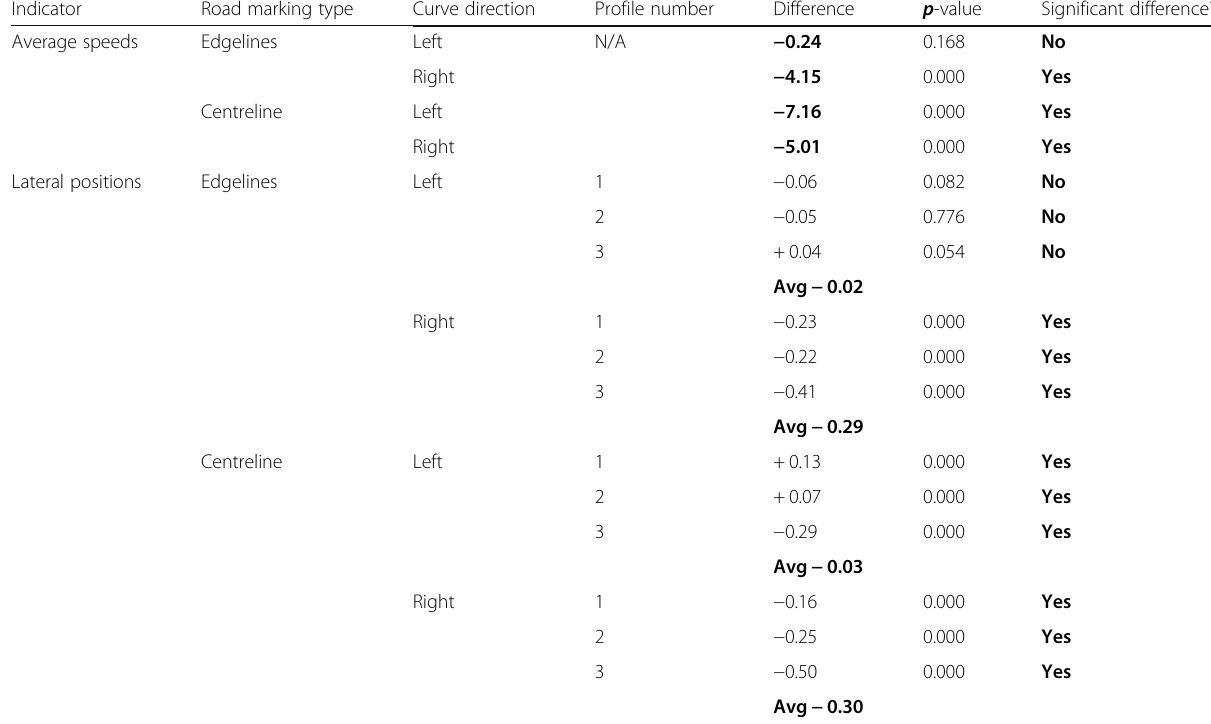
Table 4 Results of statistical testing of obtained differences Indicator Road marking type Curve direction Profile number Average speeds